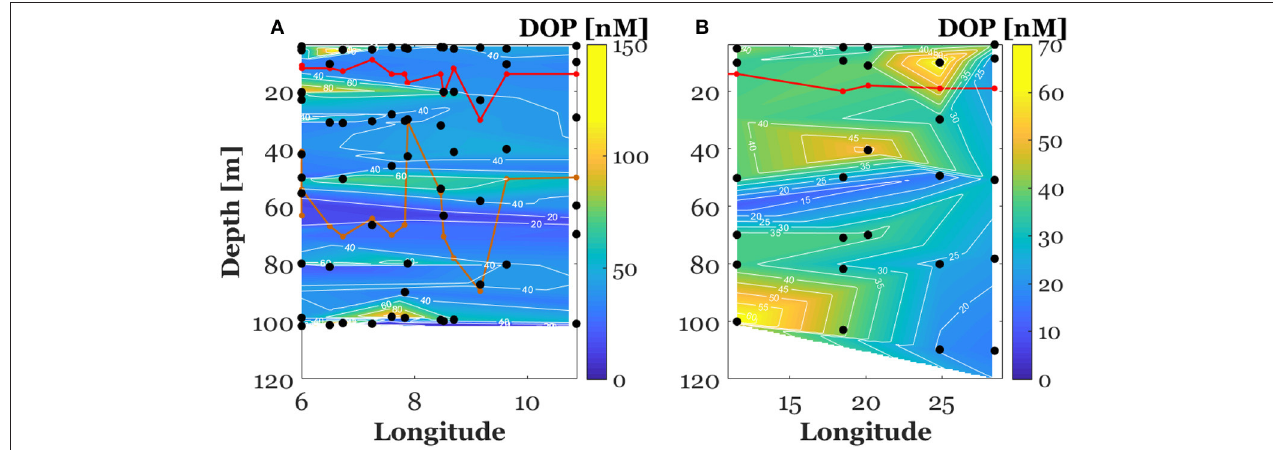
FIGURE 5 | Vertical section of dissolved organic phosphate concentrations (DOP) in the North Western Mediterranean Sea (between the surface and 100m, A ) and along the E-W transect crossing Ionian and Tyrrhenian seas (between the surface and 120m, B ). The red plot represents the mixed layer depth. The orange plot represents the phosphacline depth. Note that the scale of the color bar has been tightened to point out the negative gradient of DOP in the North Western Mediterranean Sea.